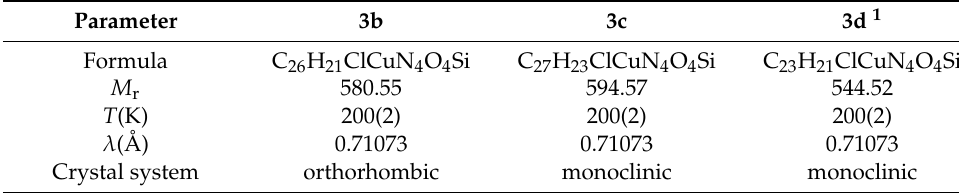
Table A3. Crystallographic data from data collection and refinement for 3b , 3c and 3d